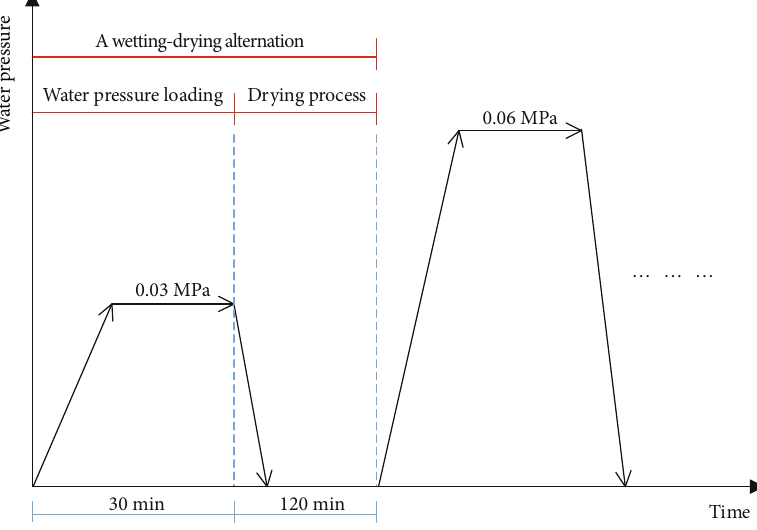
Figure 3: Schematic diagram of wetting-drying